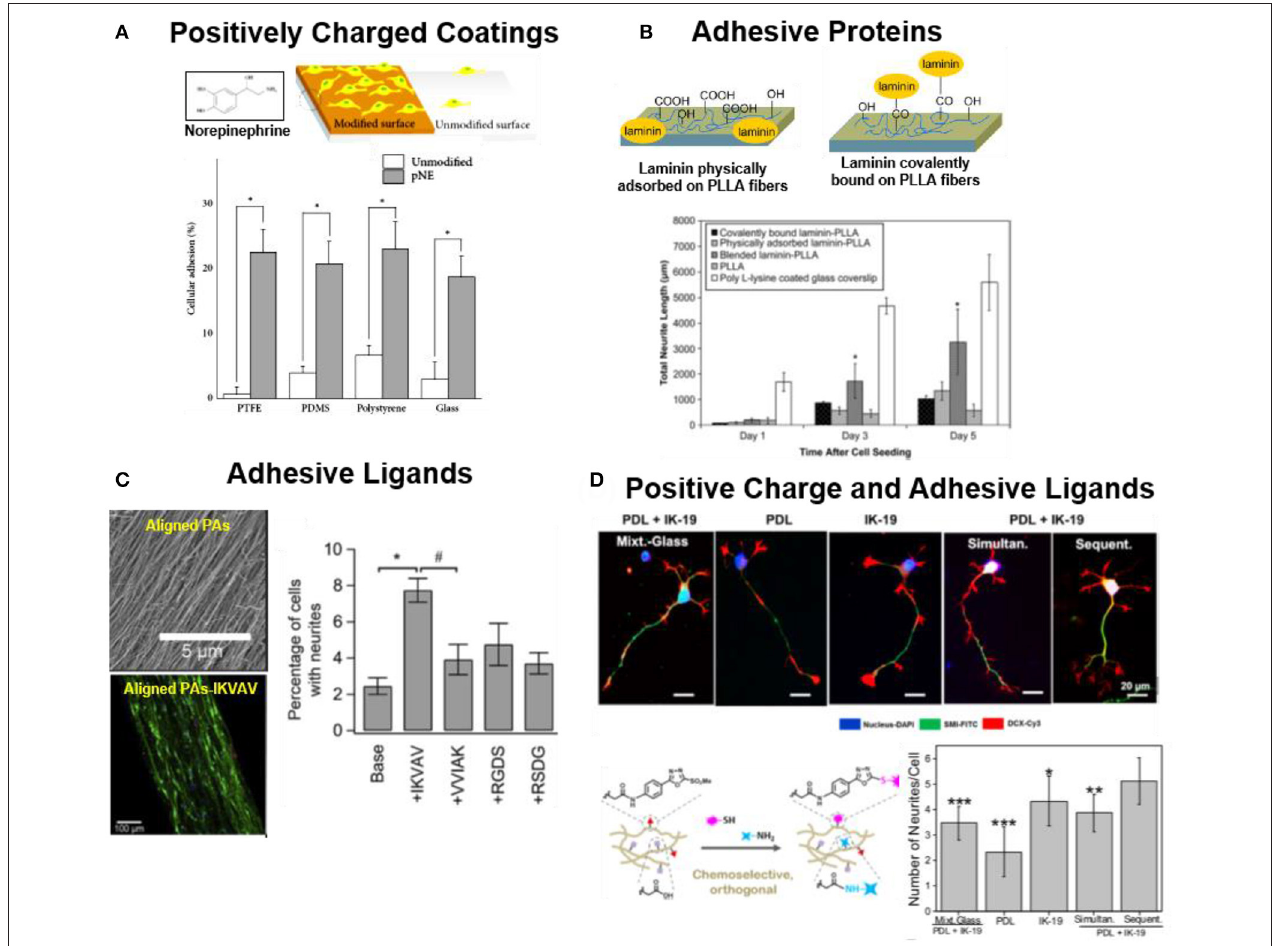
FIGURE 1 | Strategies to support adhesion of neuronal cells to biomaterials (A) hNSCs on pNE coated and uncoated substrates. pNE coating after 2h of cell seeding significantly enhance cell adhesion (Park et al., 2014) Copyright 2014, Minah Park et al.; (B) PLLA nanofibers coated or covalently functionalized with LN. LN coated substrates support adhesion and neurite extension of PC12 cells ( Koh et al., 2008) Copyright 2008, Elsevier; (C) PAs (Palmitoyl-VVAAEE-NH 2 ) functionalized with adhesive epitope to support adhesion of hippocampal neurons. Aligned PA-IKVAV significantly enhance cell adhesion and directional neurite extension during 2 days of culture ( Berns et al., 2014) Copyright 2014, Elsevier; (D) IKVAV (IK-19) and PL functionalized polyacrylamide hydrogels either by mixed (simultaneous binding) or by orthogonal coupling chemistries (sequential binding). Sequential binding of PL/IKVAV enhance the cell neurite extension of NPCs, during 5 days of culture in comparison to simultaneous binding ( Farrukh et al., 2017b) Copyright 2017, American Chemical